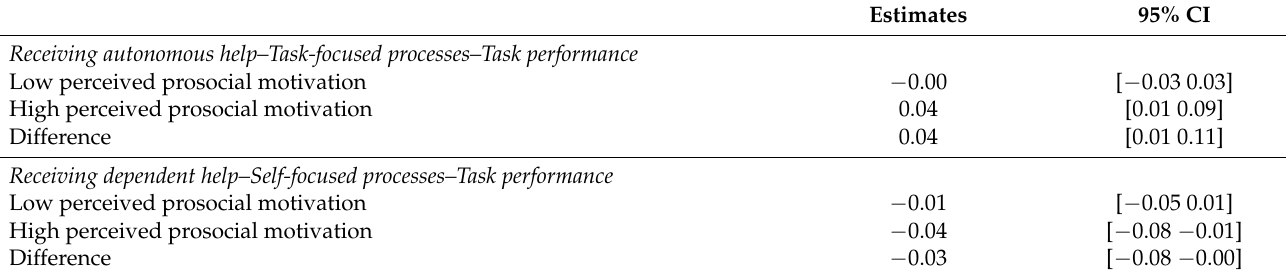
Table 5. Conditional Indirect Effect